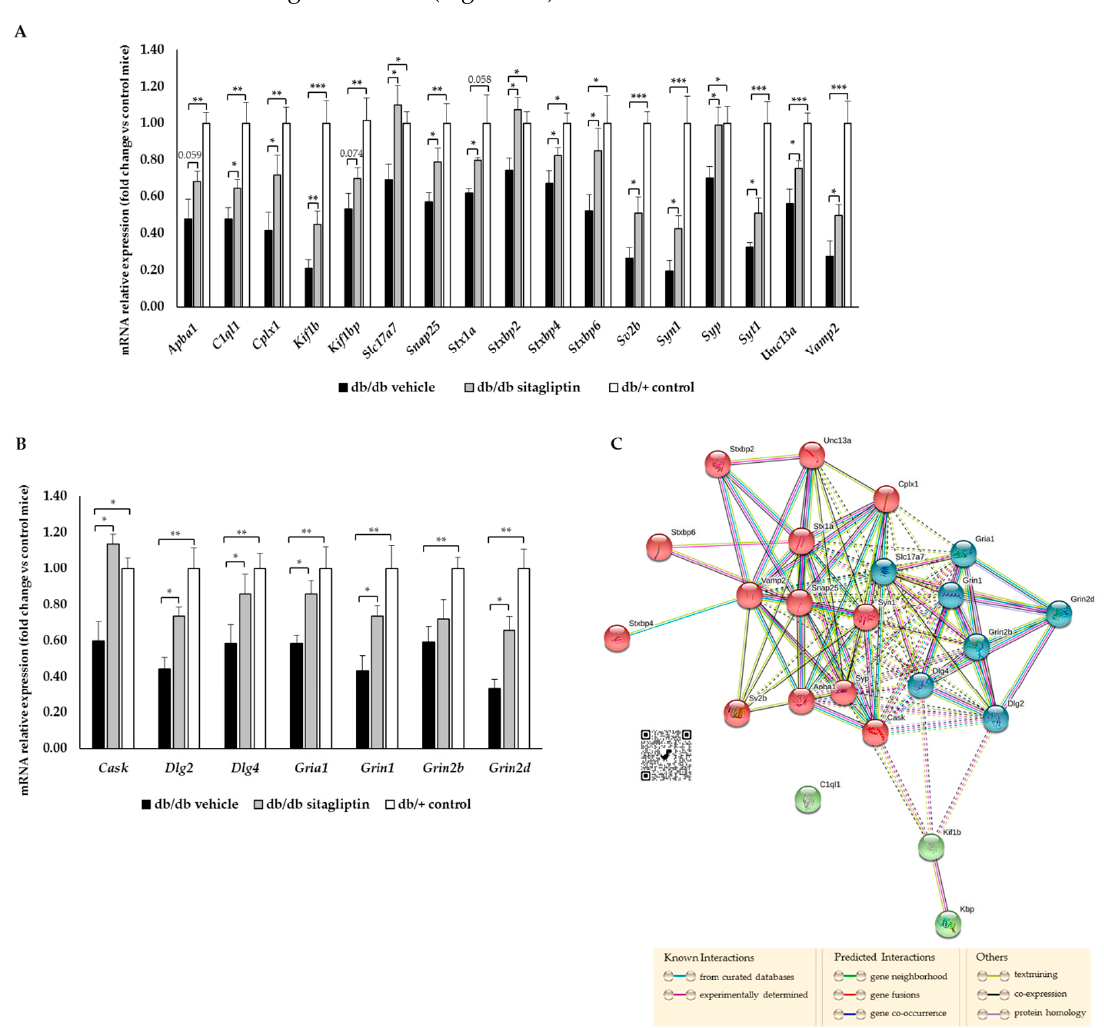
Figure 7. Study of gene expression. ( A ) RT-PCR analysis of genes related to synapse formation and neurotransmission at presynaptic level in db/db mice treated with vehicle (black bars) or sitagliptin eye drops (gray bars) and in non-diabetic mice (white bars) ( n = 4). * p < 0.05, ** p < 0.01, *** p < 0.001. ( B ) RT-PCR analysis of genes associated with neurotransmission at postsynaptic level in db/db mice treated with vehicle (black bars) or sitagliptin eye drops (gray bars) and in non-diabetic mice (white bars) ( n = 4). * p < 0.05, ** p < 0.01. ( C ) Gene interactions of studied genes (STRING ver. 11.5). The red cluster displays genes related to presynaptic proteins, the blue cluster displays those related to postsynaptic proteins and green cluster displays those related to proteins involved in synapse formation. Dashed lines represent interactions between genes from different clusters, while solid lines are the interactions of genes of the same